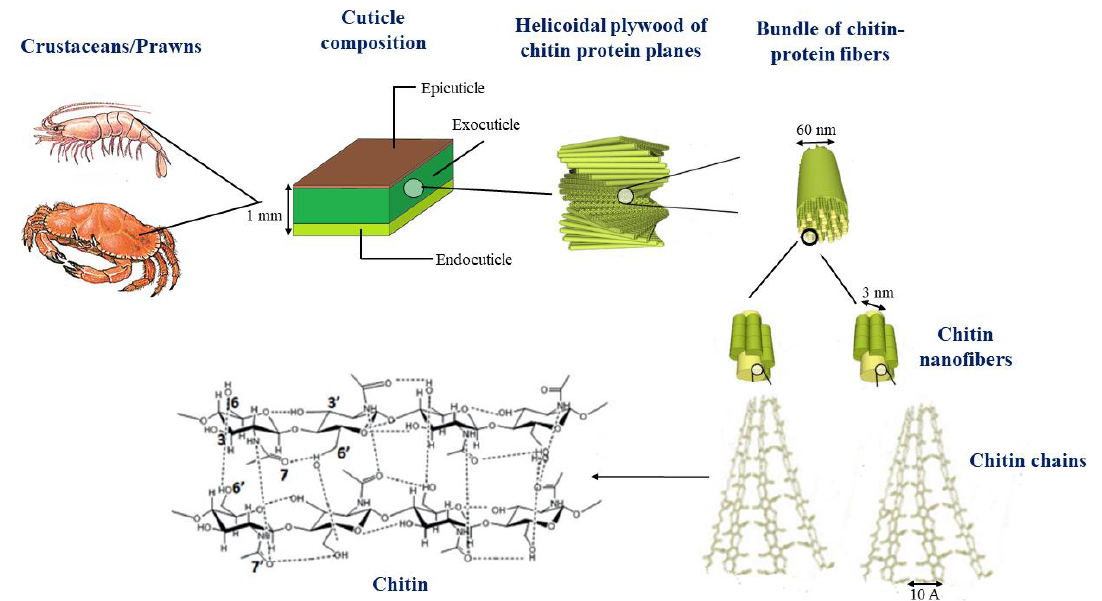
Figure 1. Structural composition and arrangement of chitin in the shell of crustaceans.